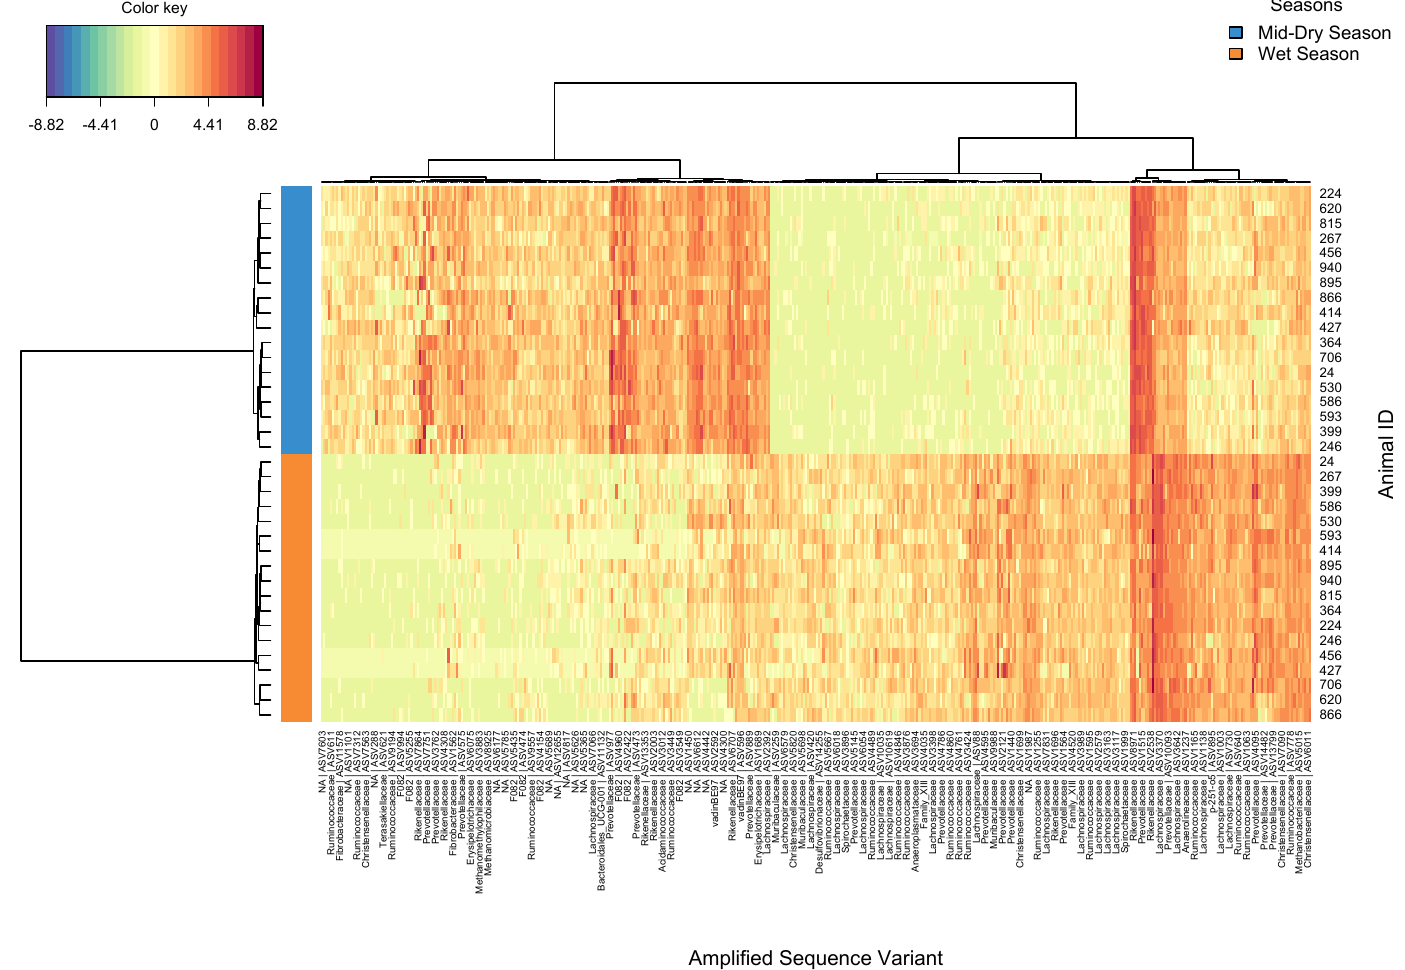
Figure 6. Clustering analysis using heatmap based on the bacterial ASVs significantly di ff erent from animals grazing in the mid-dry and wet